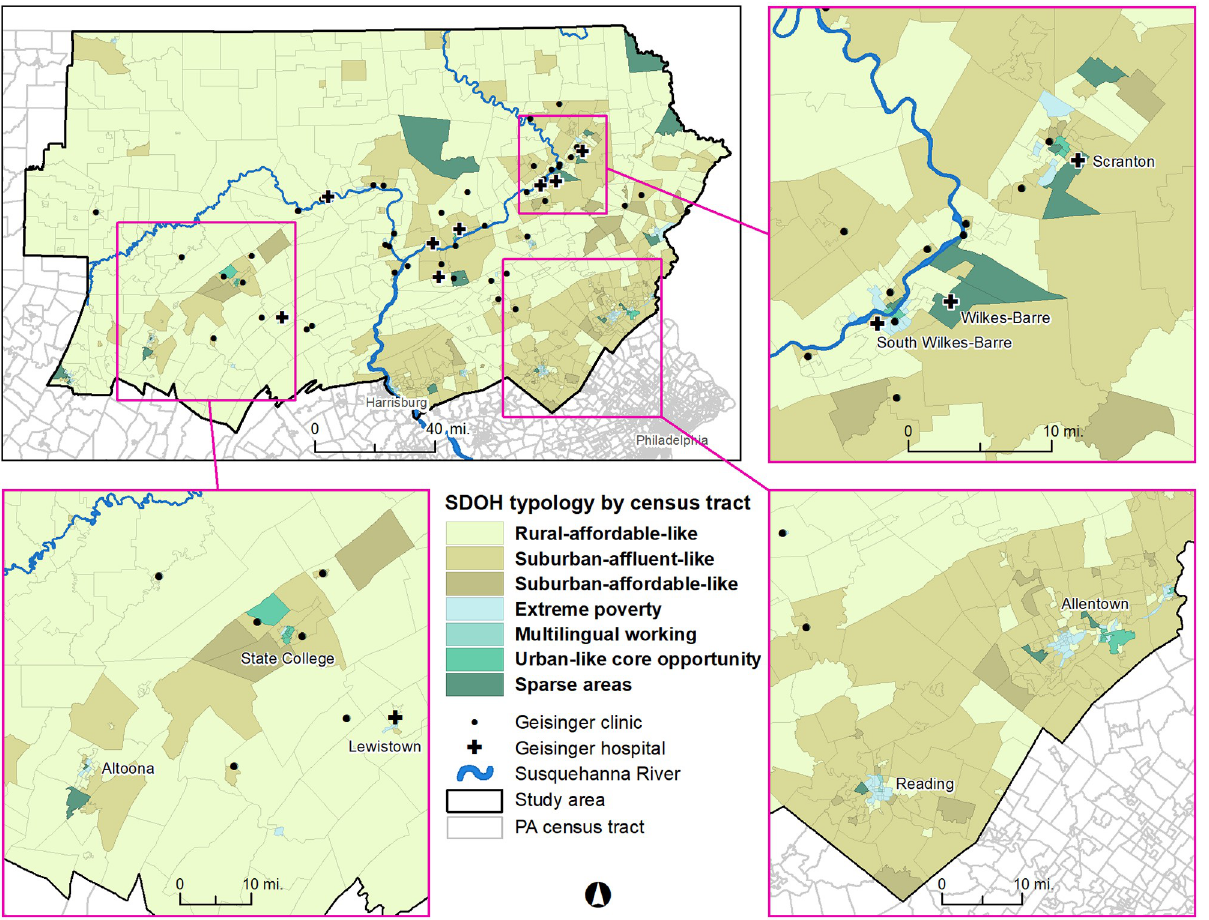
Fig 2. SDOH census tract typology in 37-county study region. There were seven typology categories (“SDOH typology by census tract” in legend). The categorization of census tracts used Jenks optimization [40], which divided data into groups to minimize within class variance and maximize between class